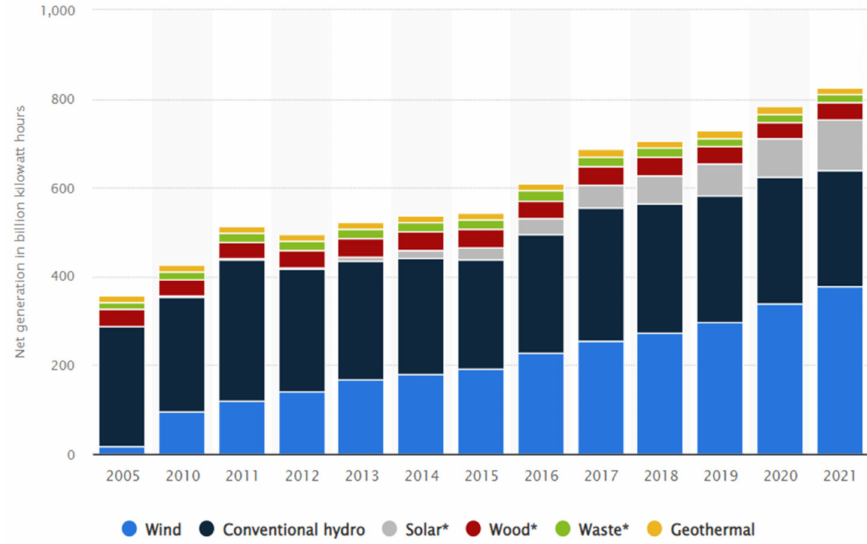
Figure 3. Renewable energy production by source. Asterisk (*) shows the estimated